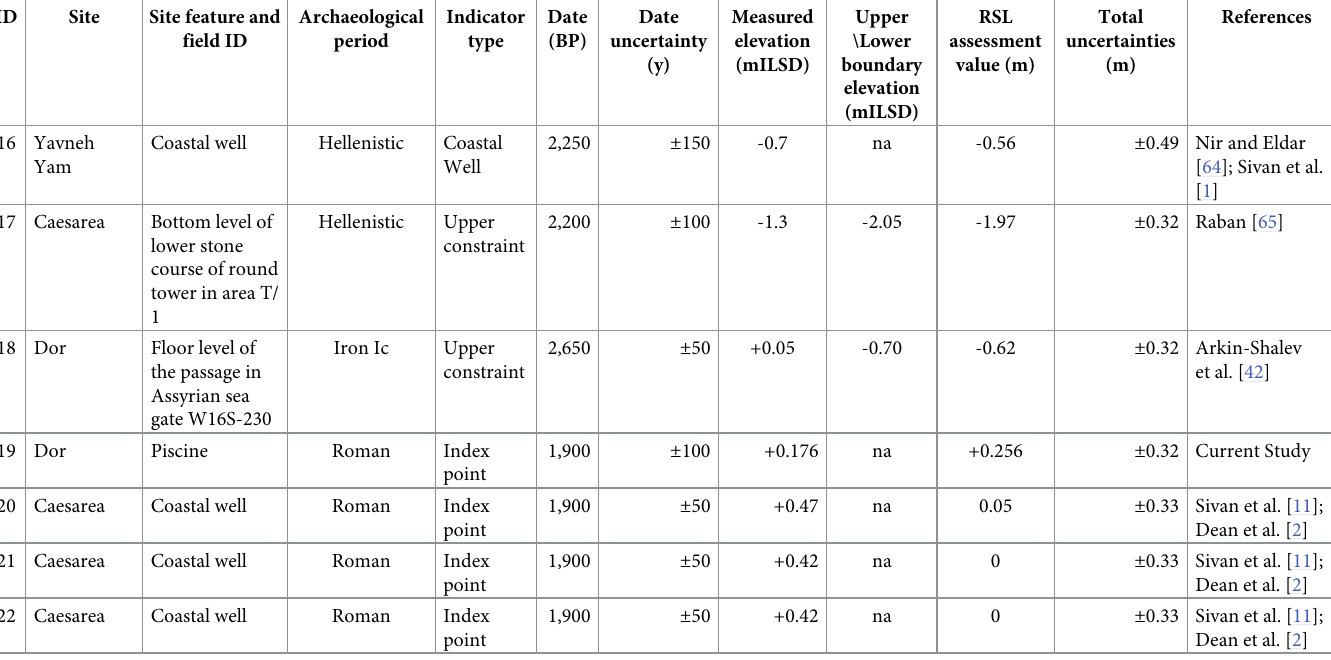
The table includes: Site name, archeological features, functional period and uncertainty, the measured elevation of the base, feature boundary elevation for calculating past sea level and total uncertainties: The total elevation uncertainties were calculated based on Dean et al. [2]. For the full details presented in the table, please refer to S1